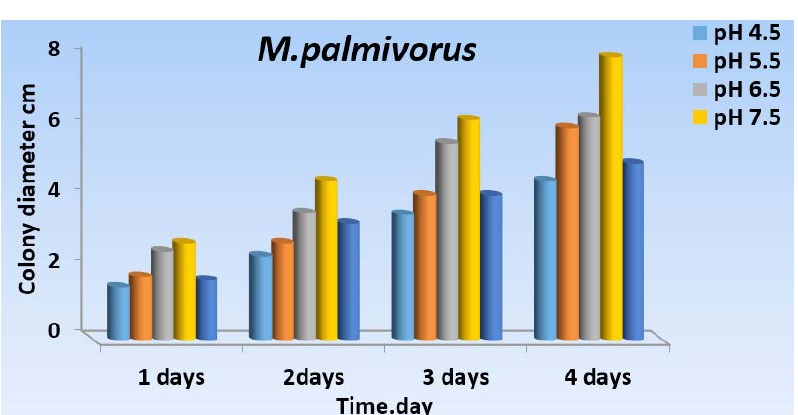
Fig. 5B. Effect of different pH levels (4.5, 5.5, 6.5, 7.5, and 8.5) on growth diameter of M. palmivorus after 4 days of incubation (LSD(0.05)=0.377)